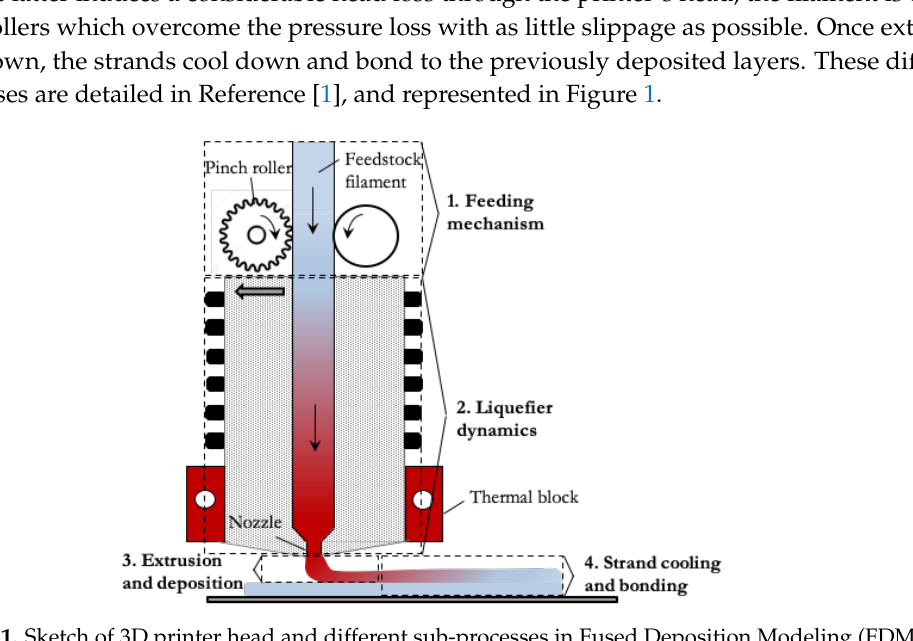
Figure 1. Sketch of 3D printer head and different sub-processes in Fused Deposition Modeling